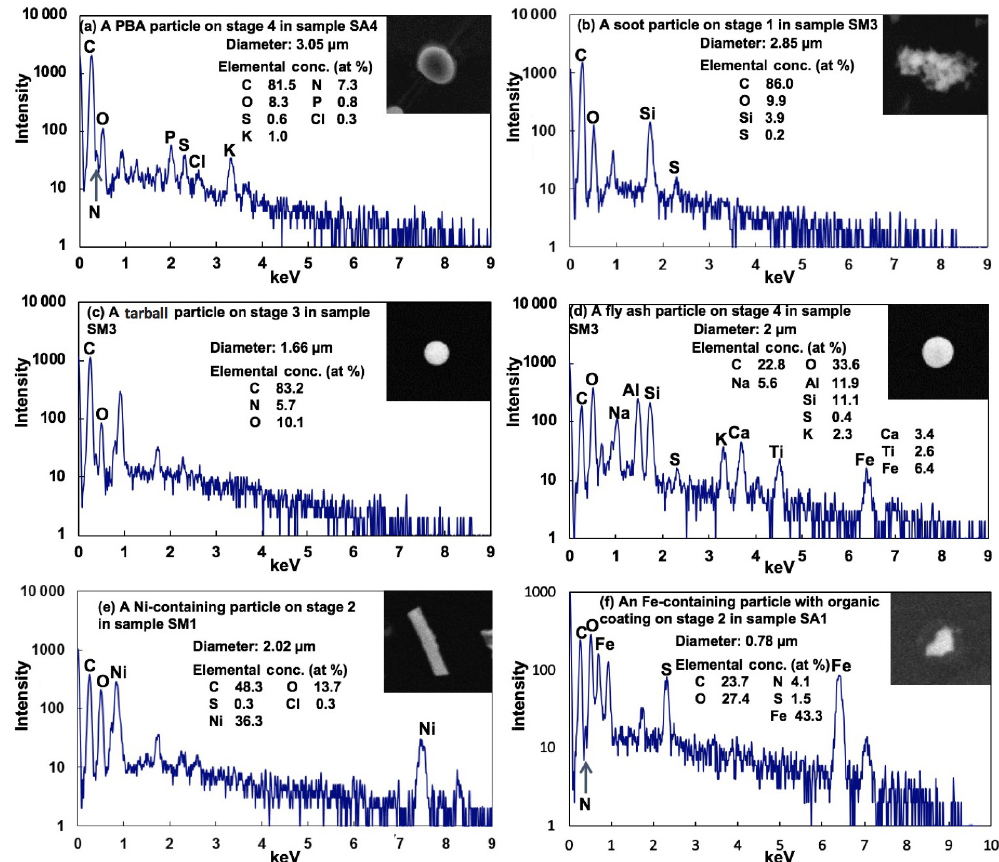
Figure 11. SEIs, X-ray spectra, and element atomic concentrations of (a) PBA, (b) soot, (c) tarball, (d) fly ash, (e) Ni-containing particles, and (f) Fe-containing